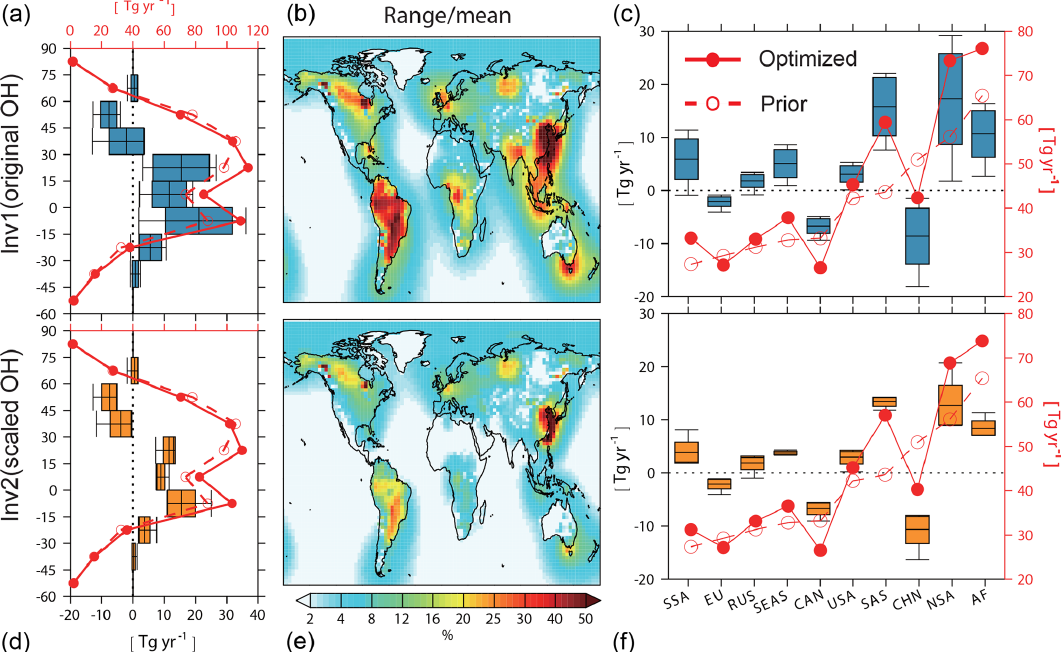
Figure 3. Zonal (a, d) , and regional averages (c, f) of CH 4 emissions calculated by Inv1 (a, c) and Inv2 (d, f) with eight OH fields from July 2000–June 2002. (a, c, d, f) Prior (dashed red line) and mean optimized (solid red line) CH 4 emissions for every 15 ◦ latitudinal band and 10 regions, respectively. USA: America, CAN: Canada, EU: Europe, RUS: Russia, CHN: China, SEAS: Southeast Asia, SAS: South Asia, NSA: northern South America, SSA: southern South America, AF: Africa. The full names of the abbreviations are applicable to all figures hereafter. The differences between prior and optimized emissions (optimized minus prior) are shown by the box plots (defined in Fig. 1). Prior and optimized emission values correspond to the right axes and their differences correspond to the left axes. (b, e) The ratio of the uncertainty range of emissions estimated with different OH fields (max–min) in each grid cell calculated by Inv1 (b) and Inv2 (e) to multi-inversion mean CH 4 emissions.